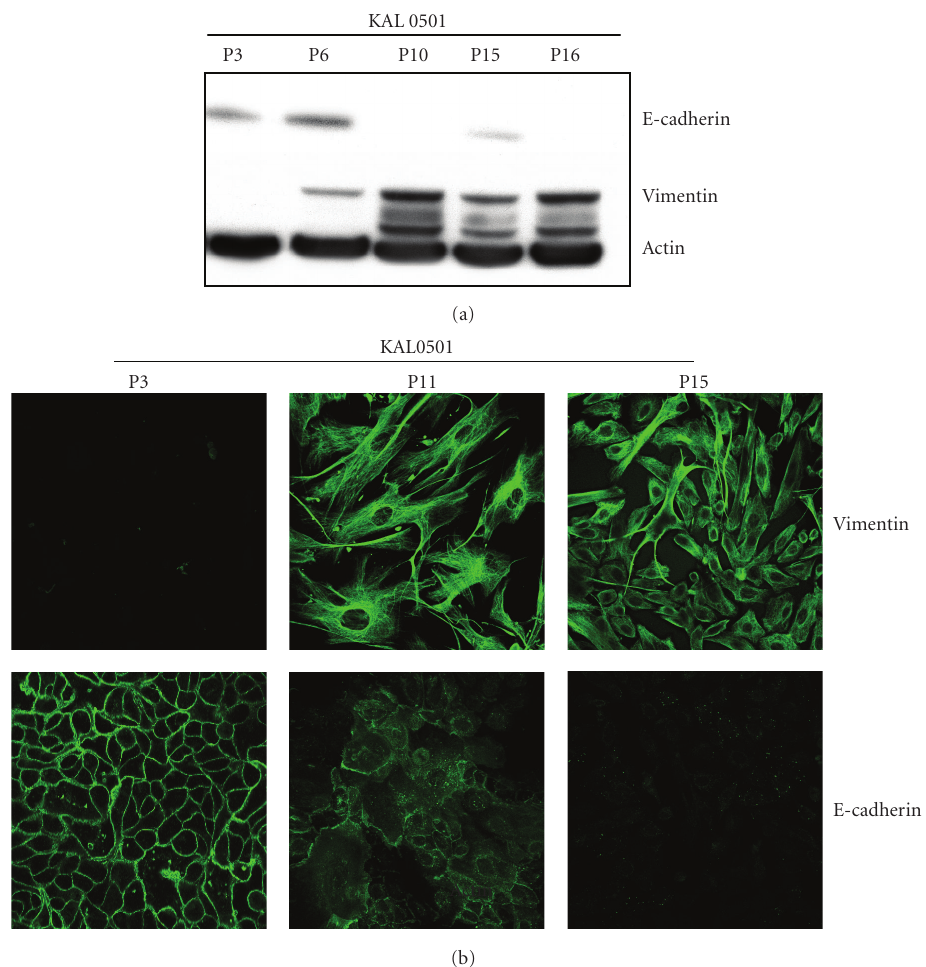
Figure 4: Expression of vimentin and E-cadherin in KAL0501 at di ff erent passages in western blot and immunofluorescence. (a): E-cadherin expression level of KAL 0501 decrease from P3 to P16 on contrary to vimentin expression which increase. (b): picture (confocal microscope x25) of KAL0501 at P3, P11, and P15 cultured on monolayer. E-cadherin disappears progressively with the passage and vimentin appear at P11.